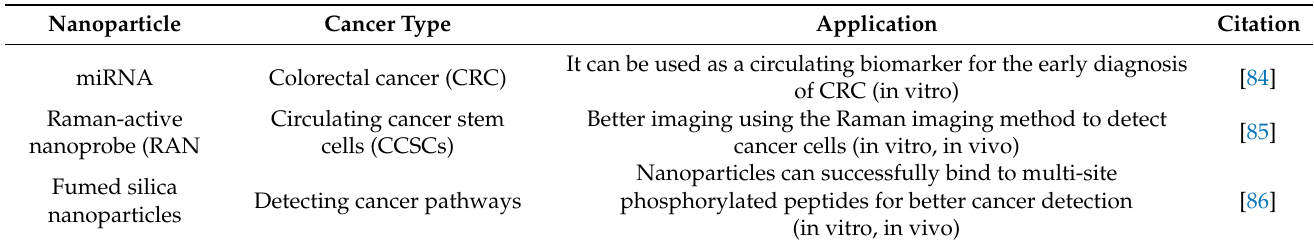
Table 10. Application of other types of nanoparticles in cancer